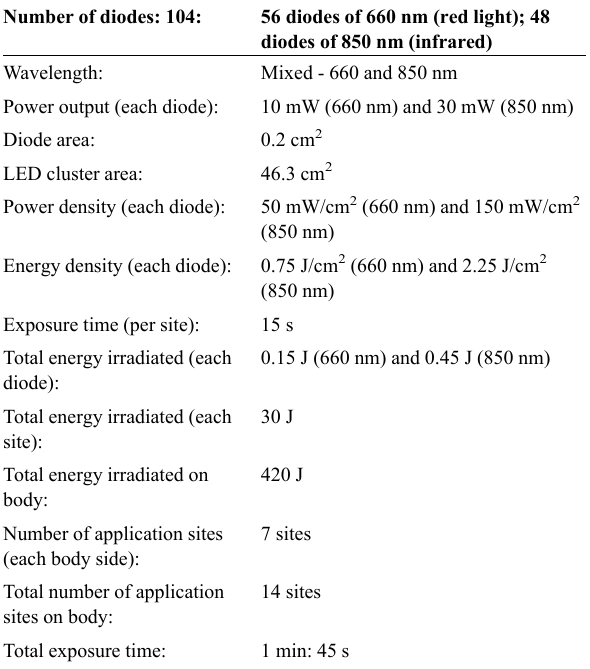
Table 1 - Parameters of PBM application.